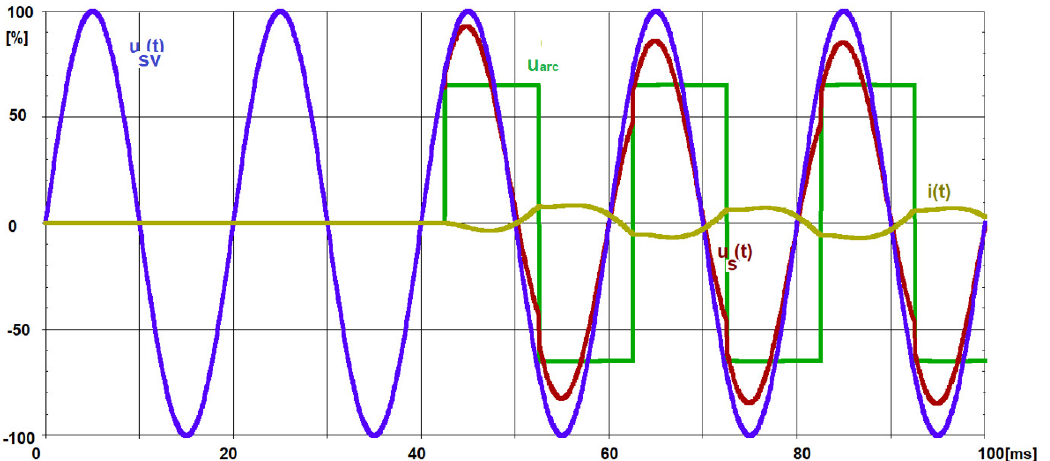
Figure 24. Oscillograms of the supply (source) voltage U SV ( t ), the arc furnace supply voltage U S ( t ),